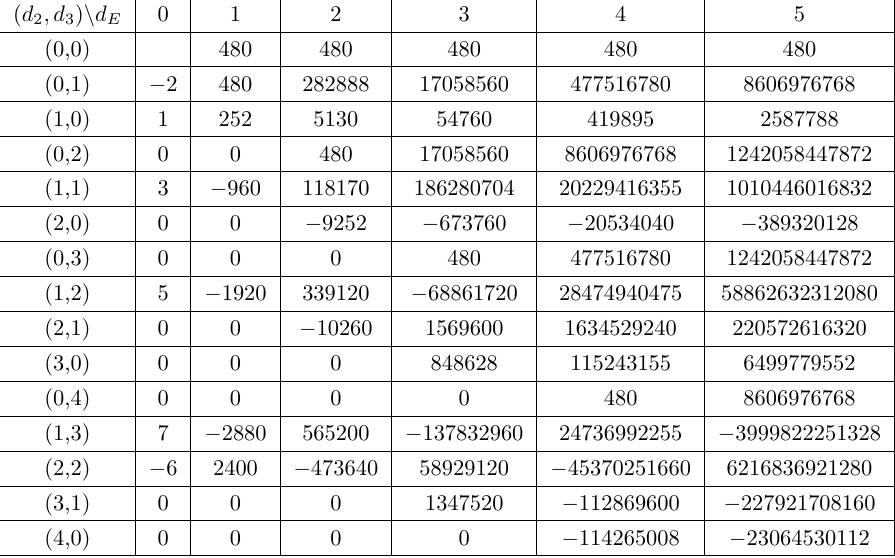
Table 12 . The refined GV numbers n g L ,g R